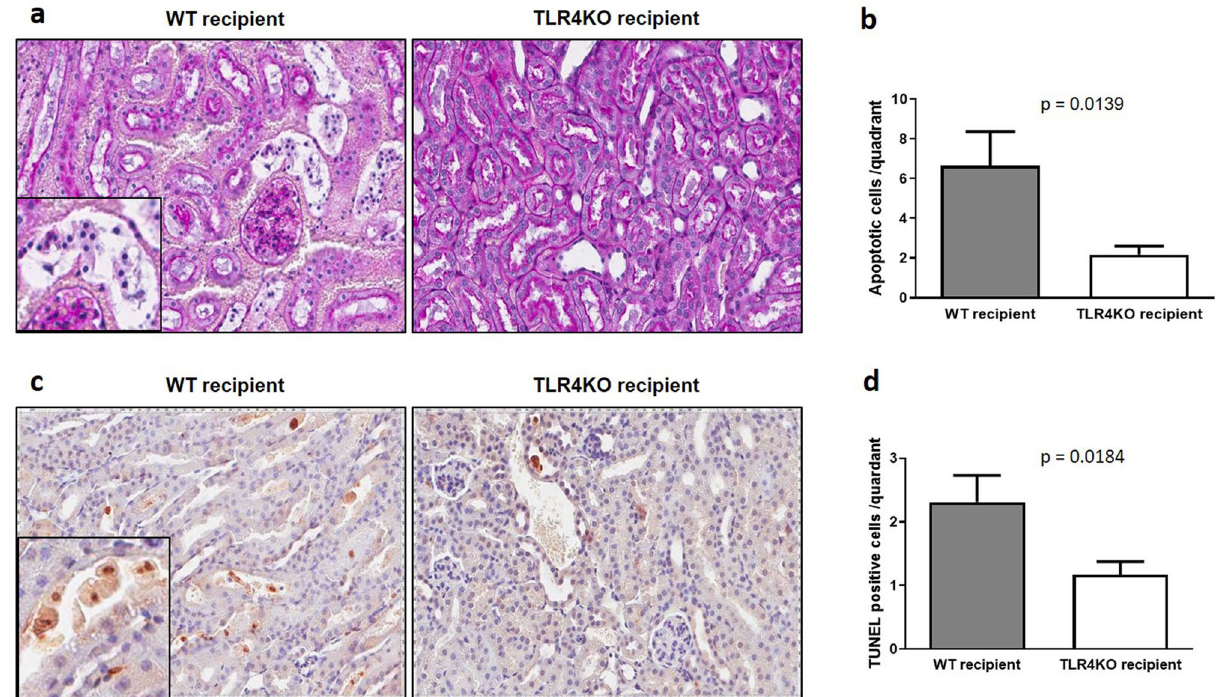
Figure 2. Assessment of tubular cell apoptosis: ( a ) Representative renal histology pictures of transplanted wild type and TLR4 knockout kidneys. Renal tubular apoptotic cells were counted based on morphological criteria (as described in the “Methods” section). ( b ) Kidneys transplanted from TLR4KO donors had significantly fewer apoptotic tubular epithelial cells compared to kidneys transplanted from wild type donors (6.655 ± 1.717 vs. 2.172 ± 0.412; * p < 0.05 vs. TLR4KO-WT). ( c ) Representative pictures of TUNEL staining (brown) demonstrating reduced staining in TLR4KO kidneys and the presence of TUNEL positive epithelial cells in the parenchyma and tubule lumen. ( d ) Kidneys transplanted from TLR4 knockout donors had significantly fewer apoptotic cells compared to kidneys transplanted from wild type donors (2.310 ± 0.421 vs. 1.172 ± 0.205; * p < 0.05 vs. TLR4KO-WT). Data were analyzed using an unpaired two-tailed Student t test. Values are means ± SEM. n per group = 7. WT–WT represents kidney transplanted from wild type donor to wild type recipient and TLR4KO-WT represents kidney transplanted from TLR4 knockout donor to wild type